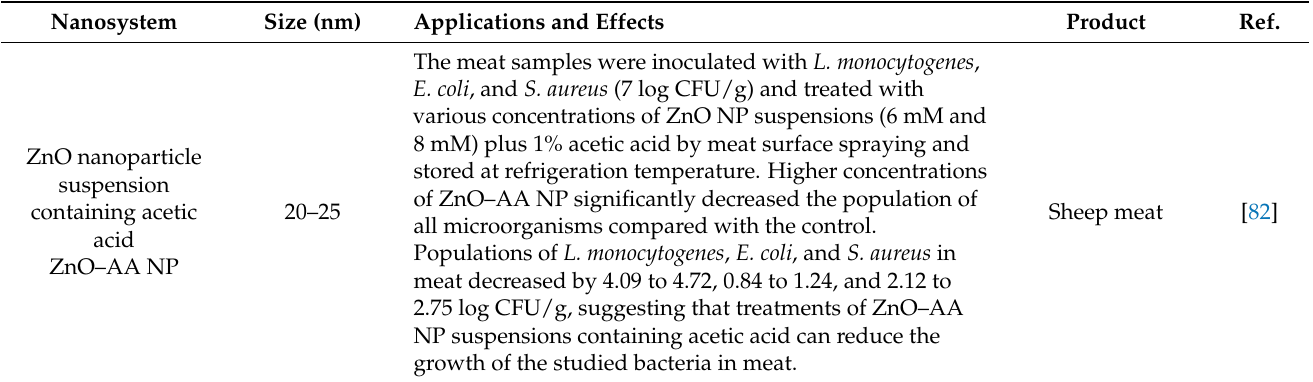
Table 4. Summary of nanosystems applied on meat and meat products and their antimicrobial effect.